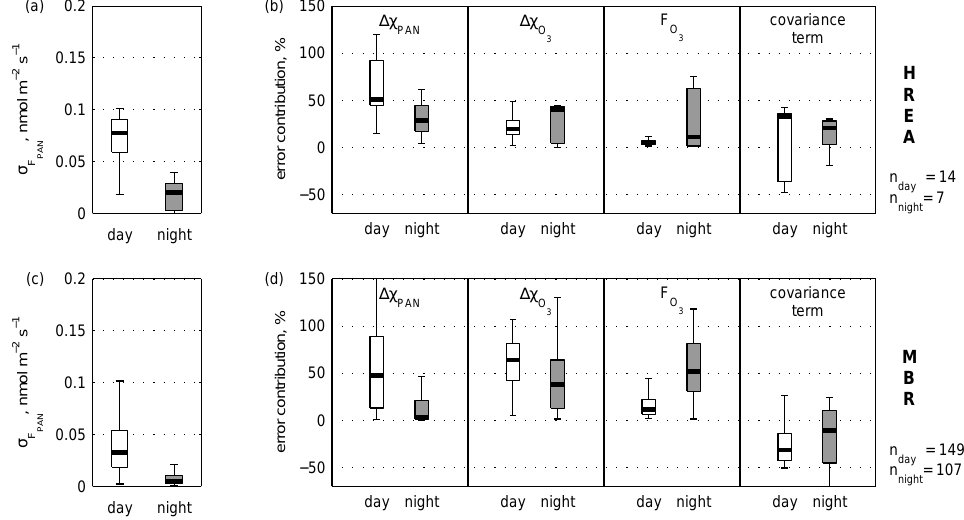
Figure 9. Boxplot statistics of random errors for the HREA (upper panel) and MBR (lower panel) measurements during day and night- time at the Mainz-Finthen grassland site. (a) and (c) : absolute random errors of the PAN flux; (b) and (d) : relative contribution to the total random flux error of the individual components used in the error propagation method (Sect. SM3 in the Supplement). The covariance term accounts for a possible correlation of the individual error terms and can be positive or negative. Values below the flux detection limit were not considered, which did not have a significant impact on the displayed boxplot